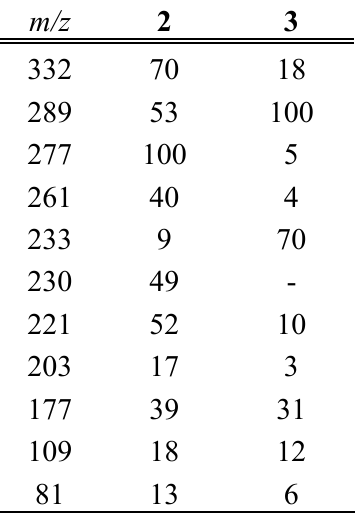
Table 1 . EIMS fragments ( m/z ) and their intensities (in %) for 2 and 3 .